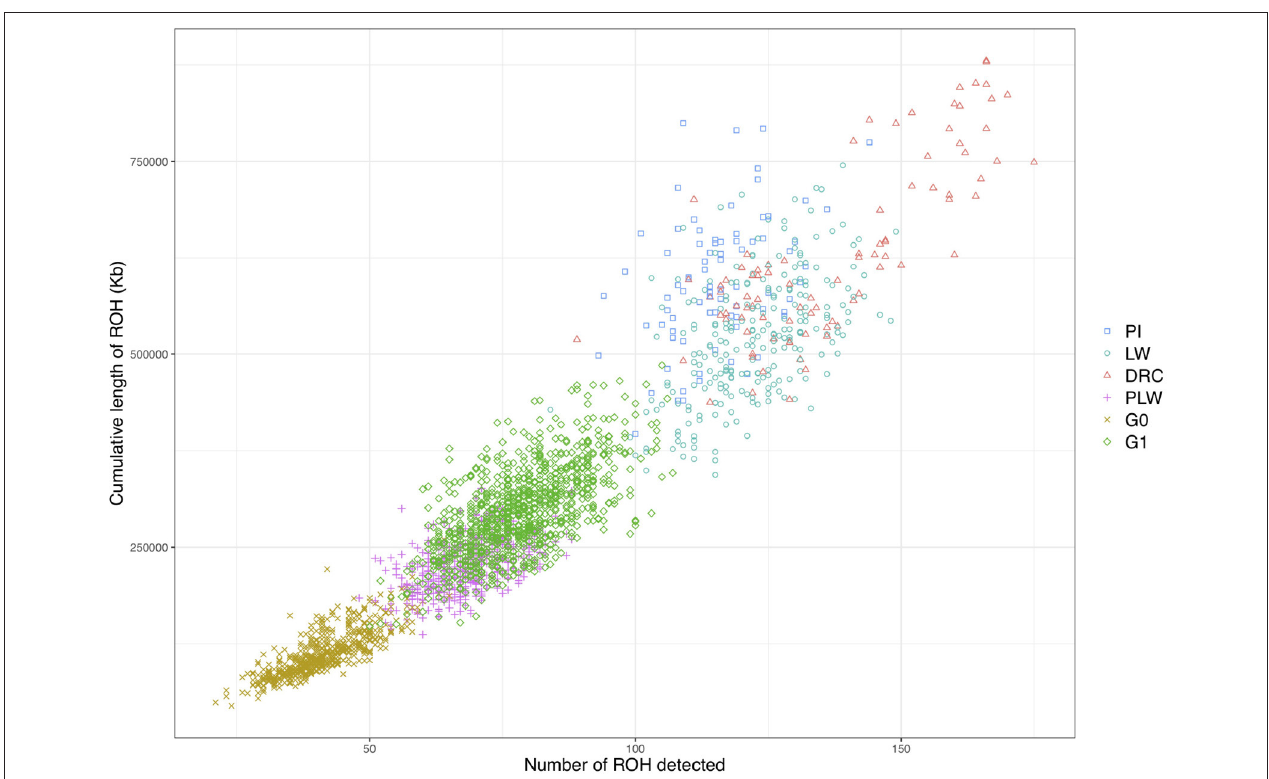
FIGURE 5 | Individual pattern of runs of homozygosity (ROH). The cumulative length of ROH is plotted against the number of ROH detected for each animal. DRC, Duroc; G0, (Pietrain × Large White) × Duroc offspring; G1, G0 × G0 offspring; LW, Large White; PI, Pietrain; PLW, Pietrain × Large White.